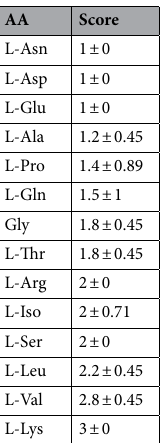
Table 1. Amino acid utilization order for P. aeruginosa 215 cultures grown on five different, chemically- defined media supplemented with various additional carbon sources. Amino acids were binned into three categories (1, 2, 3) based on the time of exhaustion, averaged between three biological replicates for each of five medium conditions, n = 15. Data can be found in supplementary material